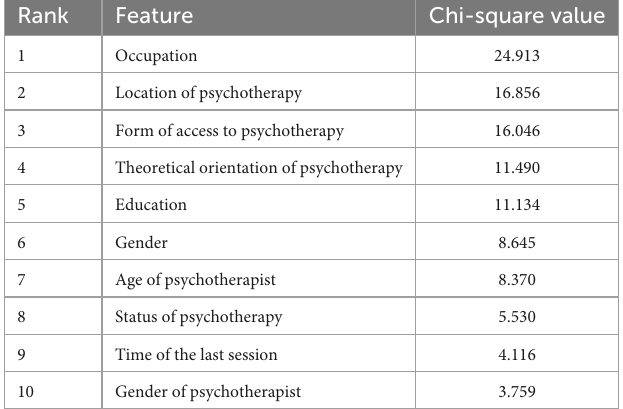
TABLE 2 The ranking of feature